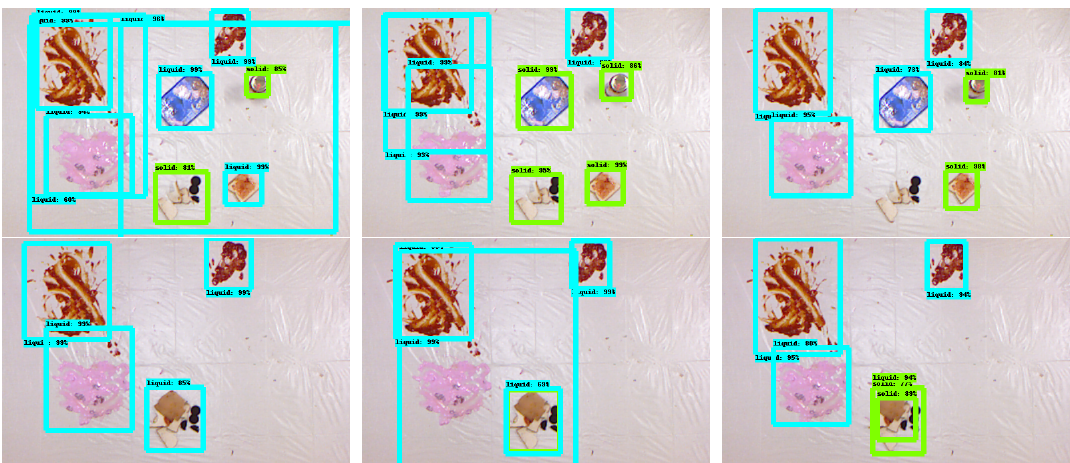
Figure 9. Predictions of three networks, Faster RCNN Resnet ( Left ), Faster RCNN Inception ( Center ), Proposed Scheme ( Right ) on the same